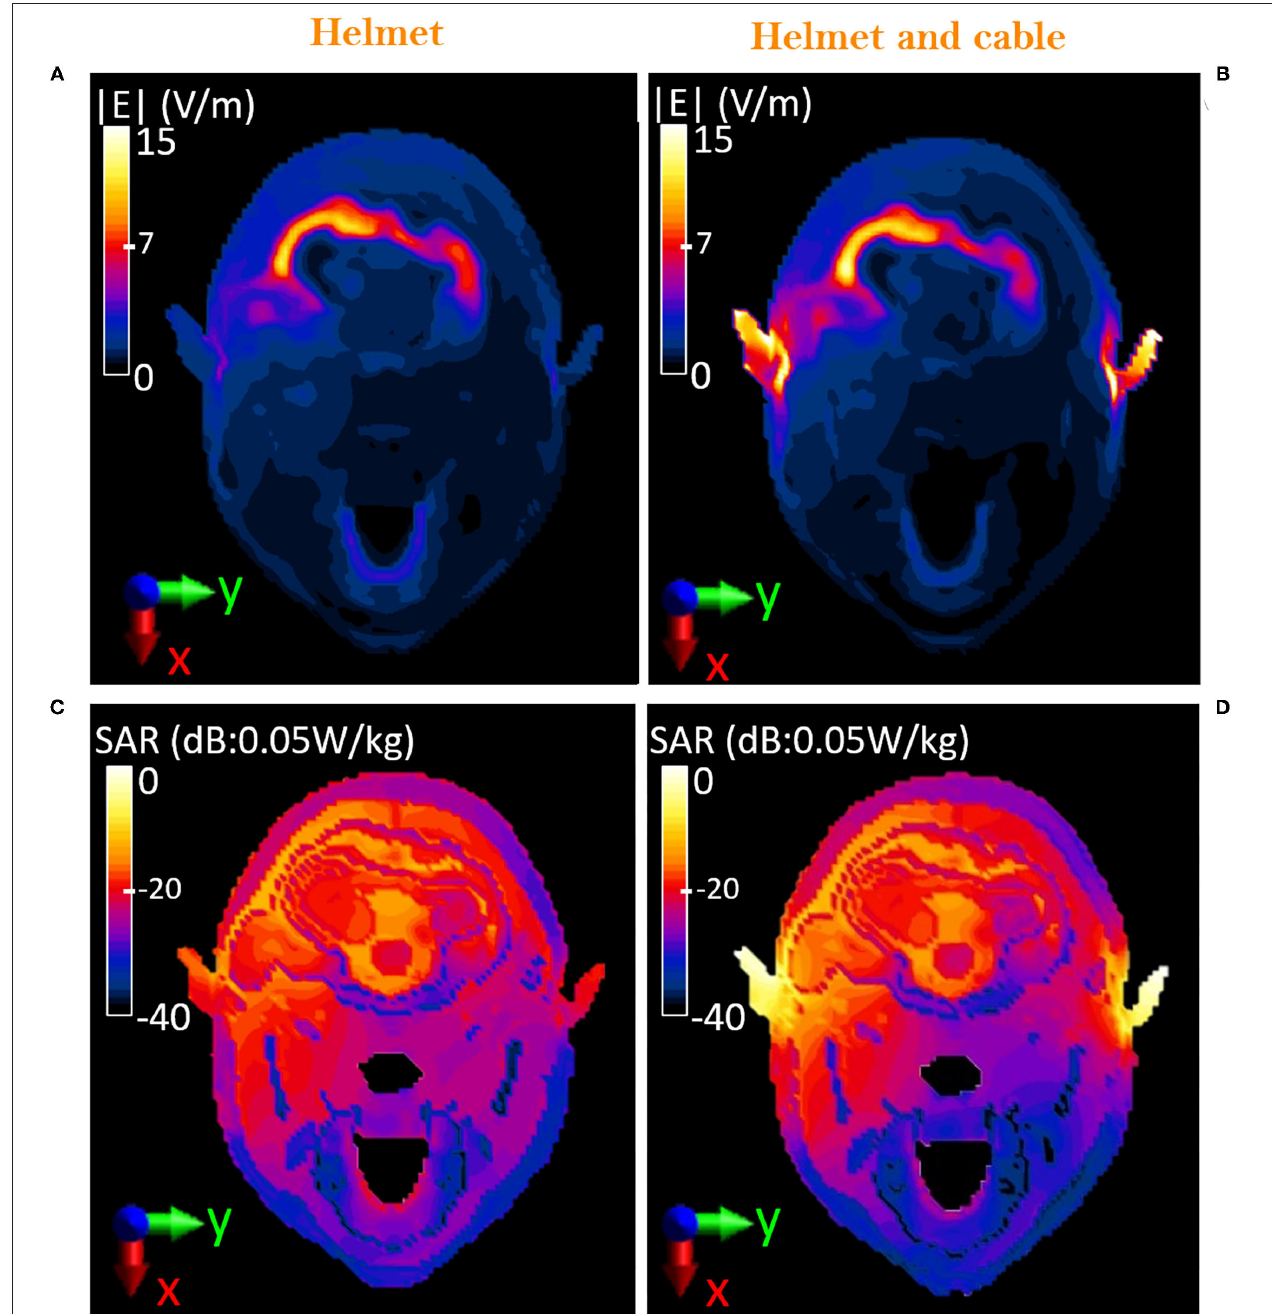
FIGURE 8 | Comparison on the axial plane, XY, between equipped military operator wearing the sole helmet and the helmet with the cabled headset. Distribution of the E-field induced inside the head of the virtual body model Duke at 65cm from the manhole (A,B) . Distribution of the local SAR induced inside the head of the virtual body model Duke at 65cm from the manhole (C,D) . Color bar for SAR is reported in logarithmic scale, considering 0.05 W/kg as the reference value (i.e., 0 dB = 0.05